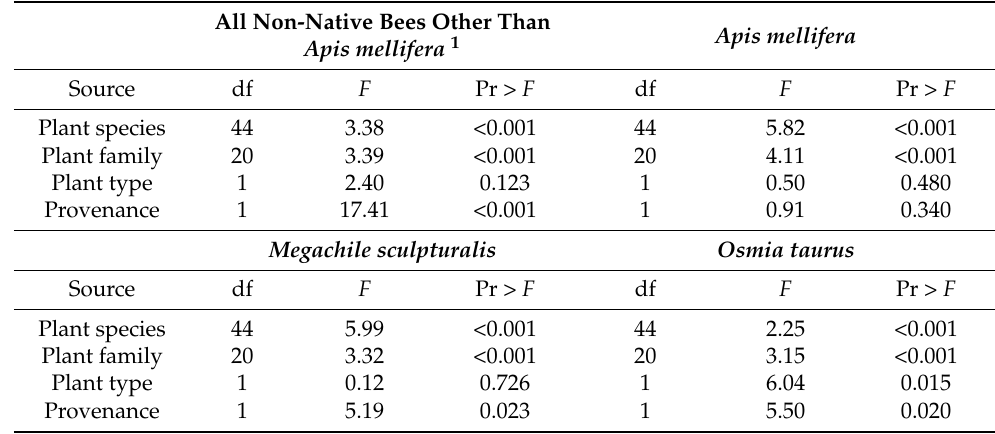
Table 2. Summary of analysis of variance for effects of plant species, plant type (tree or shrub),